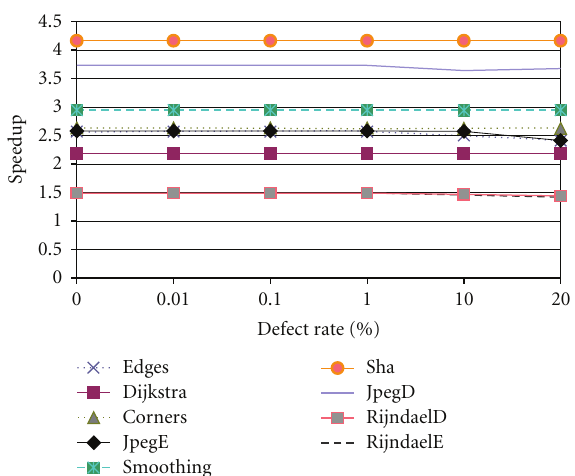
Figure 14: Speedup degradation of the FAT-array system under di ff erent defect rates—under 20% defect rate jpegE presents the highest speedup degradation with 6.5% of speedup